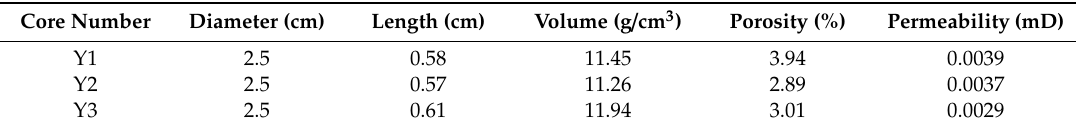
Table 1. Basic property of rocks.